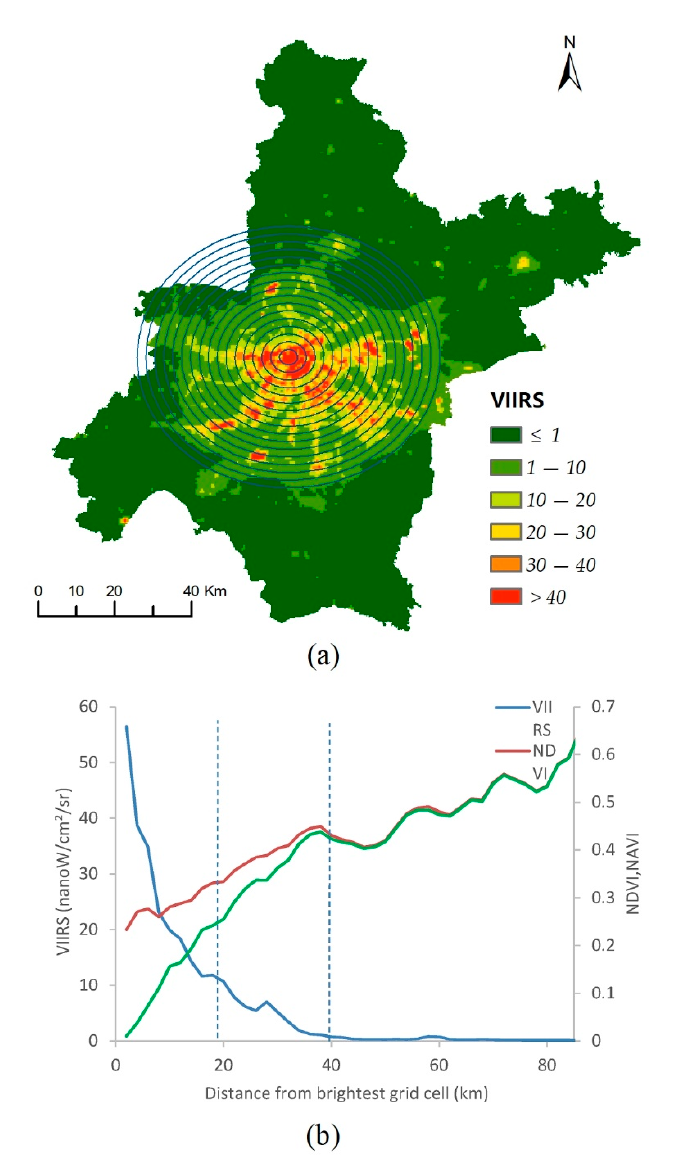
Figure 2. ( a ) Map showing the distribution of VIIRS nighttime brightness; ( b ) mean VIIRS nighttime brightness, NDVI, and NAVI every 2 km from the brightest cell . Table 1. Matrices for distribution of NDVI and VIIRS nighttime brightness .